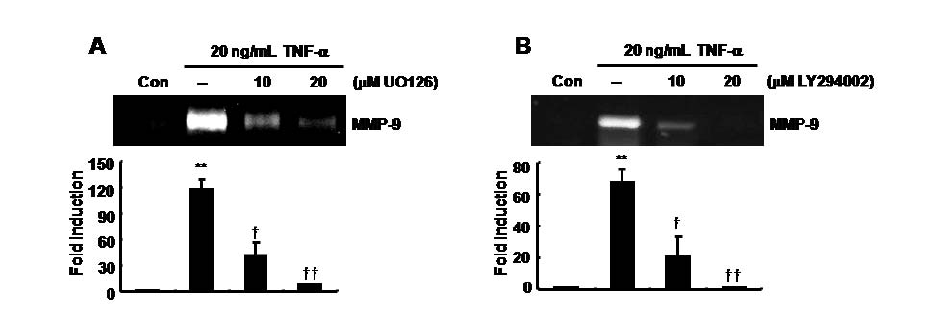
Figure 3. TNF- α -induced MMP-9 expression was decreased by UO126 and LY294002 in SNU216 gastric cancer cells. After serum-starvation for 24 h, cells were pretreated with UO126 (A) and LY294002 (B) at the indicated concentrations for 30 min and then treated with 20 μ g/mL TNF- α for 24 h. MMP-9 gelatinase activity was analyzed in culture media by zymography. These results are representative of three independent experiments. The values shown are the mean ± SEM. ** P < 0.01 vs . control, † P < 0.05, †† P < 0.01 vs . TNF- α -treated cells. Con;